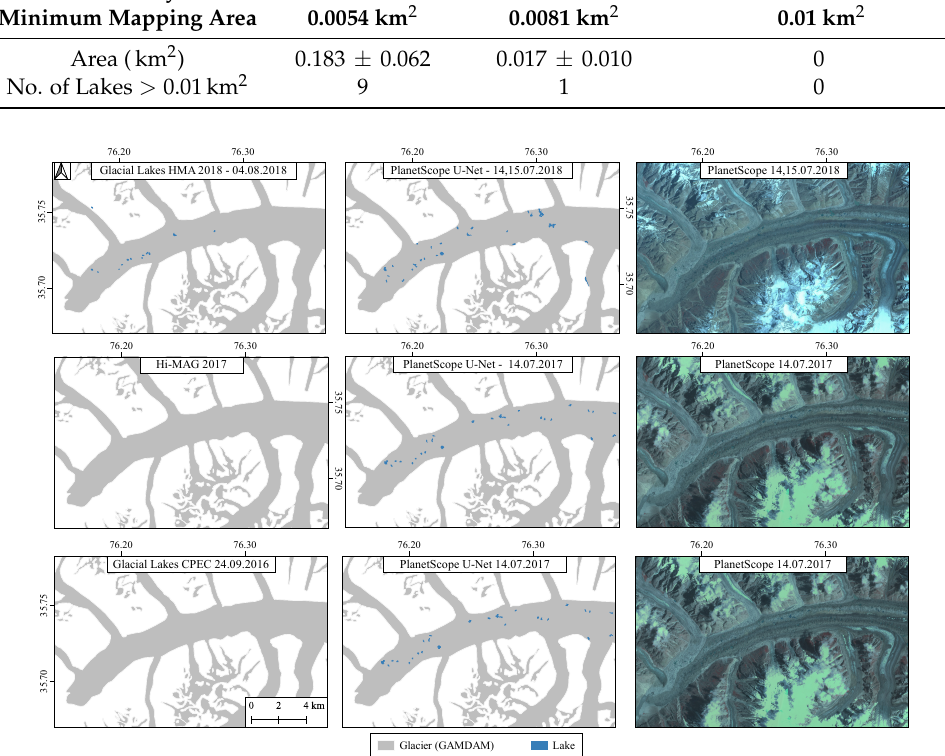
Figure 11. Comparison of the mapped supraglacial lakes with the glacial lake inventory of HMA [36], Hi-MAG database [61] and glacial lakes inventory of CPEC [62]. Surprisingly, the Hi-MAG and CPEC inventories have not detected supraglacial lakes on the Baltoro glacier. We could not find the exact dates of the images used by Hi-MAG inventory for creating the polygons. In this image, we only show lakes with an area > 0.01km 2 for U-Net model.